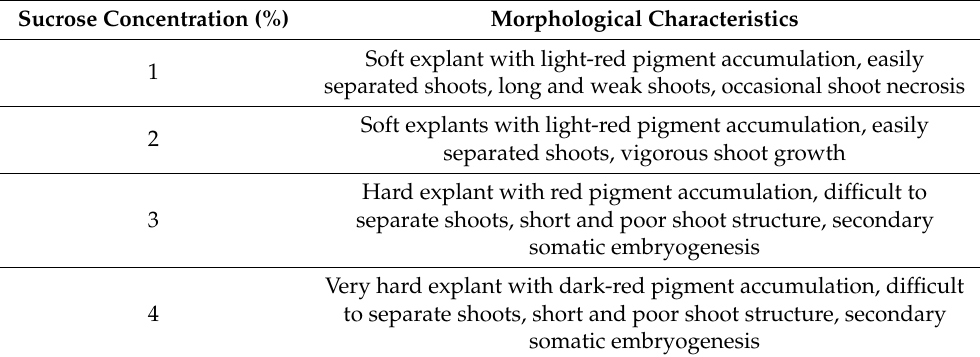
Figure 4. Somatic embryo germination of P. ginseng according to sucrose concentration in germination medium 30 days after inoculation. ( A ) 1%, ( B ) 2%, ( C ) 3%, and ( D ) 4% sucrose. Scale bars, 1 cm. Table 3. Morphological observations of P. ginseng explants and shoots according to sucrose concen- tration in germination media .